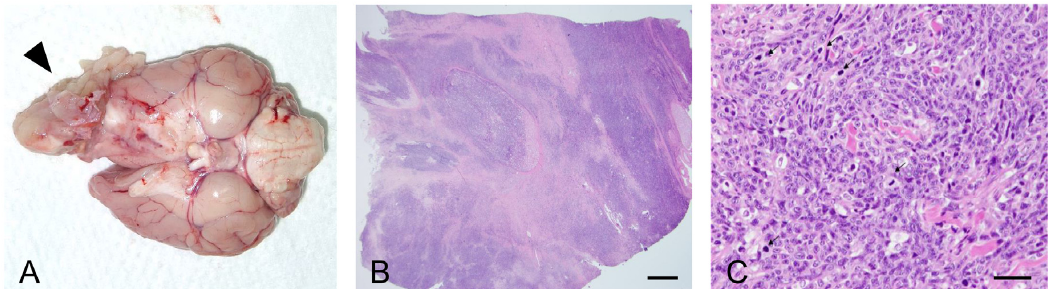
Figure 3. Gross and histopathological examination of the retrobulbar mass after necropsy. ( A ) Gross photograph of the exenterated brain (ventral aspect) specimen showed a mass (arrowhead) from the retrobulbar tissue infiltrating the cranial aspect of the left hemisphere. ( B , C ) Histopathological section of the mass (hematoxylin and eosin, B, ×12.5, scale bar = 250 μ m; C, ×400, scale bar = 50 μ m) revealed dense and poorly differentiated malignant spindle-shaped cells with frequent mitotic figures (arrows).